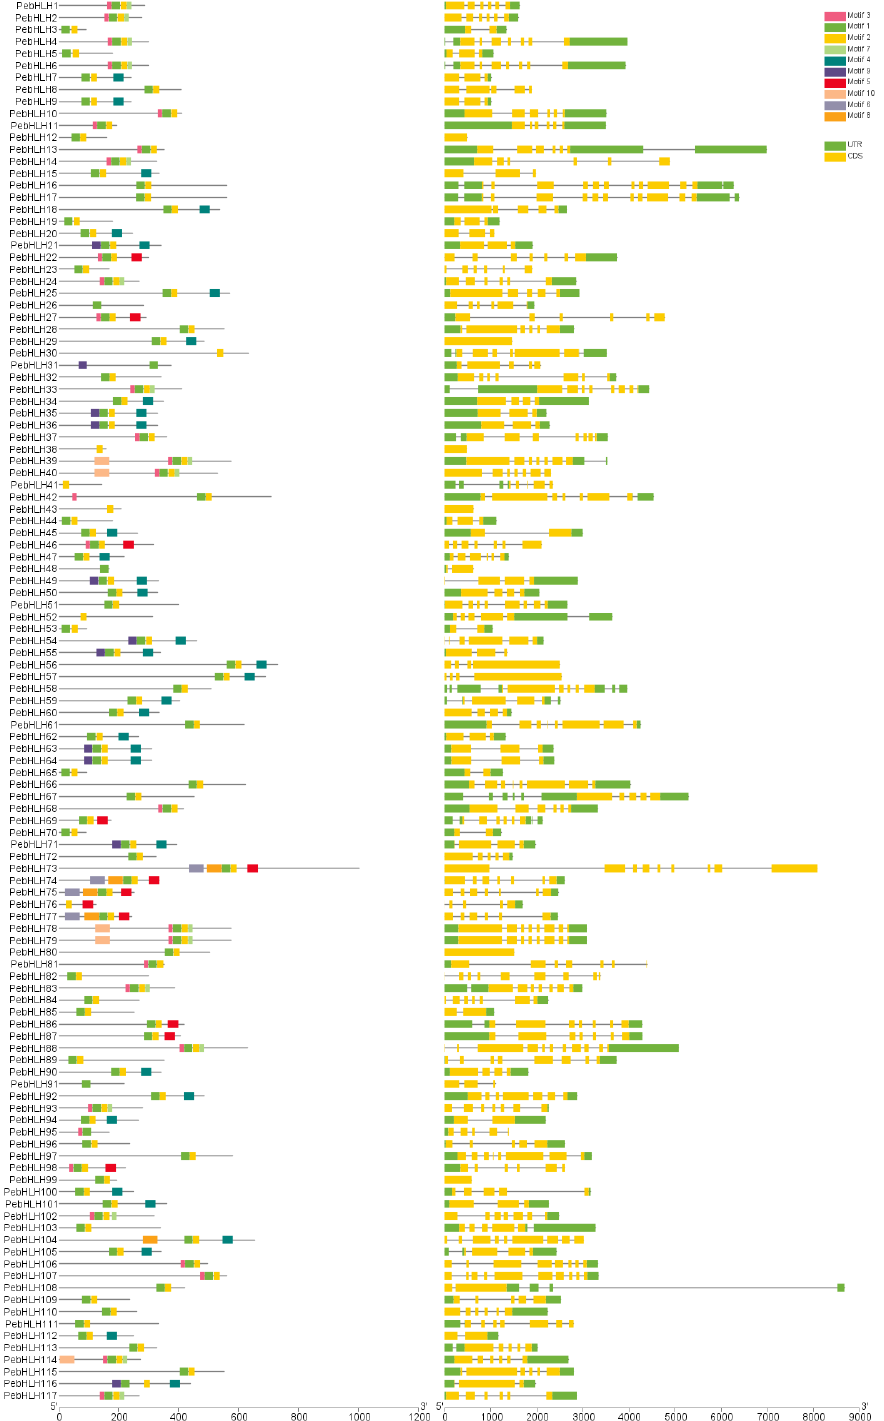
Figure 2. Phylogenetic clustering, conserved motifs, and exon/intron organization of PebHLHs . Ten color boxes indicate different motifs, green color represents 5 (cid:48) and 3 (cid:48) UTR, and yellow color and black lines represent exons and introns,